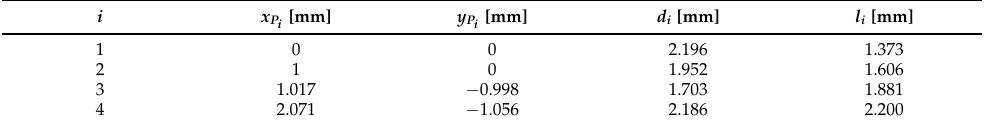
Table 2. Architecture parameters for a 4-RR structure having 28 real and distinct assembly configura- tions (compare with Table 1).